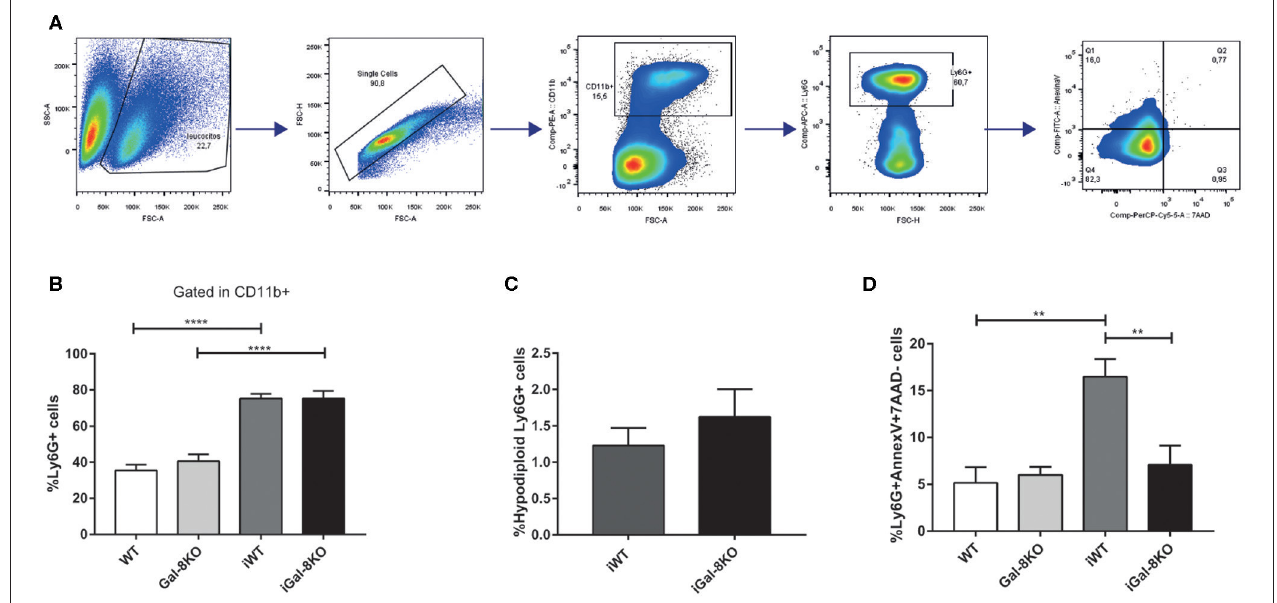
FIGURE 9 | Analysis of preaparesis in peripheral blood neutrophils from Trypanosoma cruzi -infected Gal-8KO and wild-type (WT) mice. (A) Flow cytometry gating strategy for determining preaparesis in neutrophils. (B) Percentage of Ly6G + neutrophils. (C) Measurement of hypodiploid cells. (D) Preaparesis was analyzed by